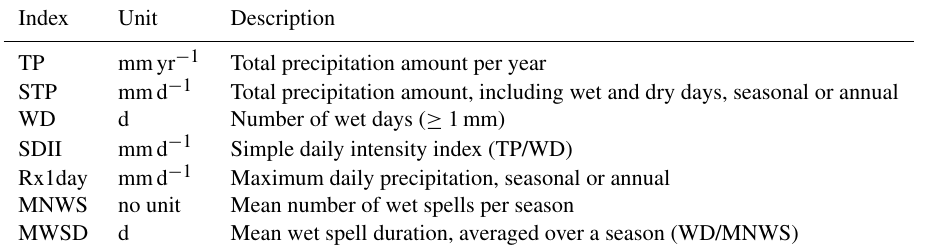
Table 1. Annual and seasonal precipitation indices analysed in this study. Precipitation is the sum of solid and liquid precipitation. These definitions follow the recommendation by the World Meteorological Organization (Peterson et al., 2001; http://etccdi.pacificclimate.org/list_ 27_indices.shtml, last access: 12 November